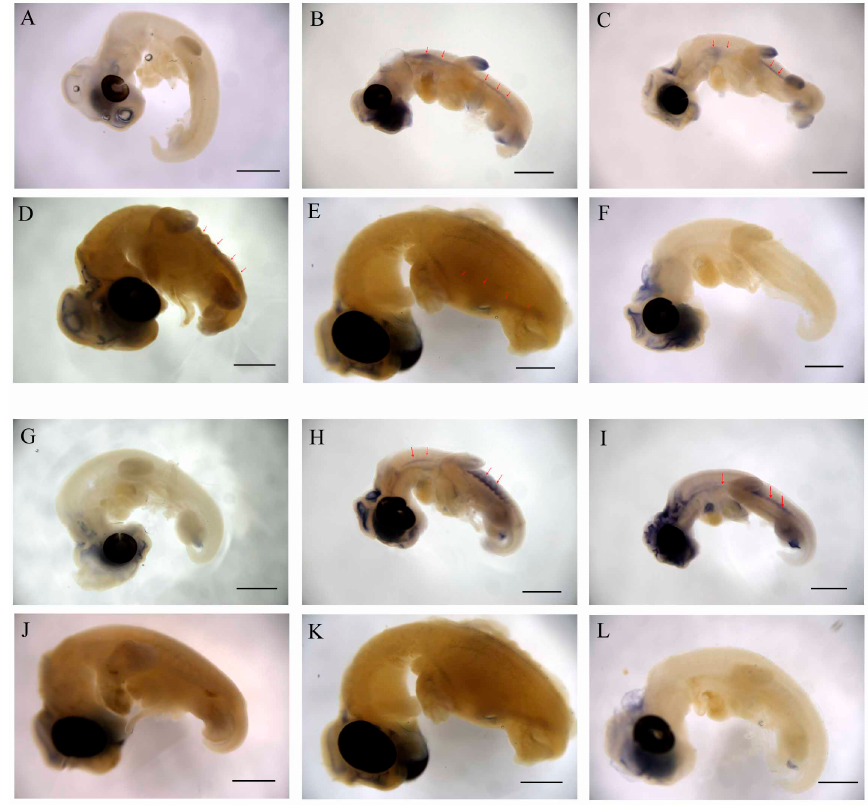
Figure 4. Wnt5a and Fgf10 specific expression in the CR. ( A – E ) Expression and location of Wnt5a in stages TK13 to TK17 CR of Chinese soft-shell turtle; the red arrow shows the position of Wnt5a in the CR. ( F ) Positive probe as a control. ( G – K ) Expression and location of Fgf10 in stages TK13 to TK17 CR of Chinese soft-shell turtle, the red arrow shows the position of Fgf10 in the CR. ( L ) Positive probe as a control. The scale bar is 2 millimeters.